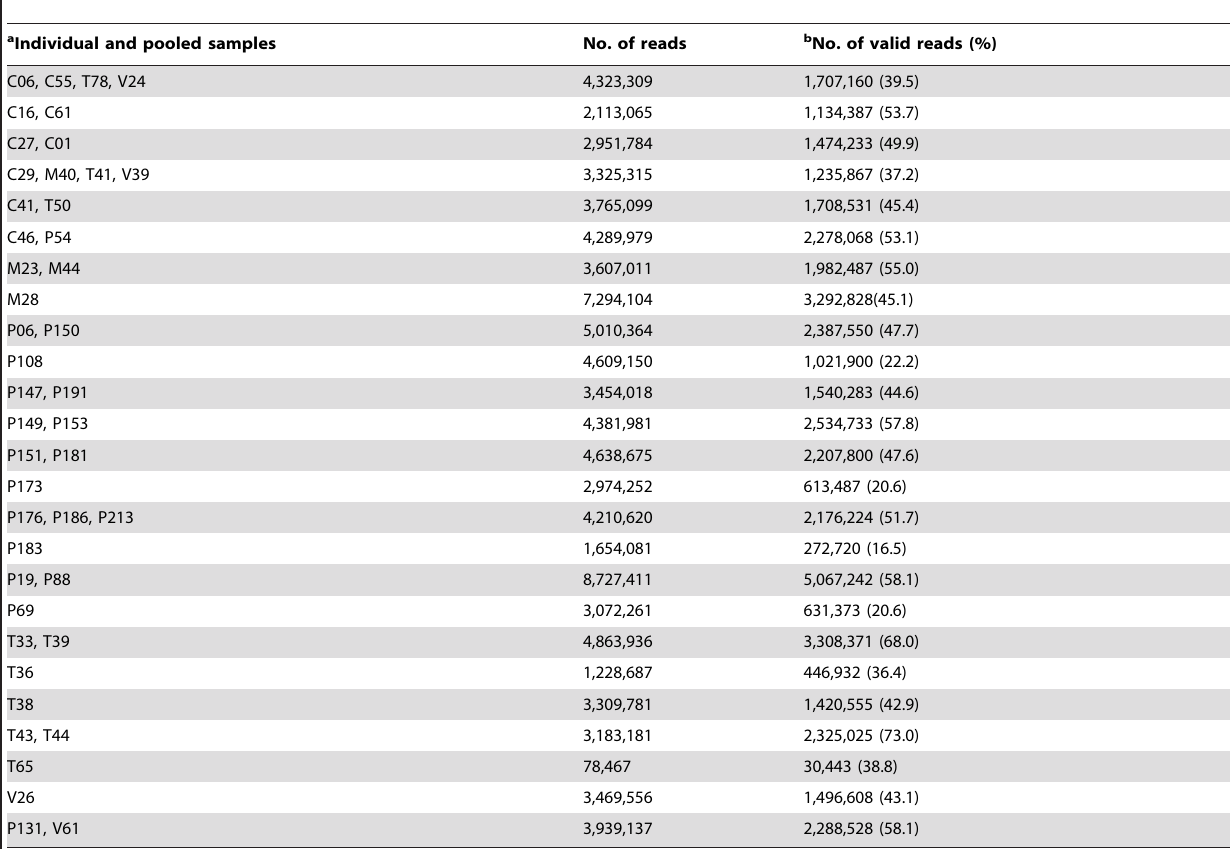
Table 3. DNA reads obtained after NGS sequencing of URTI